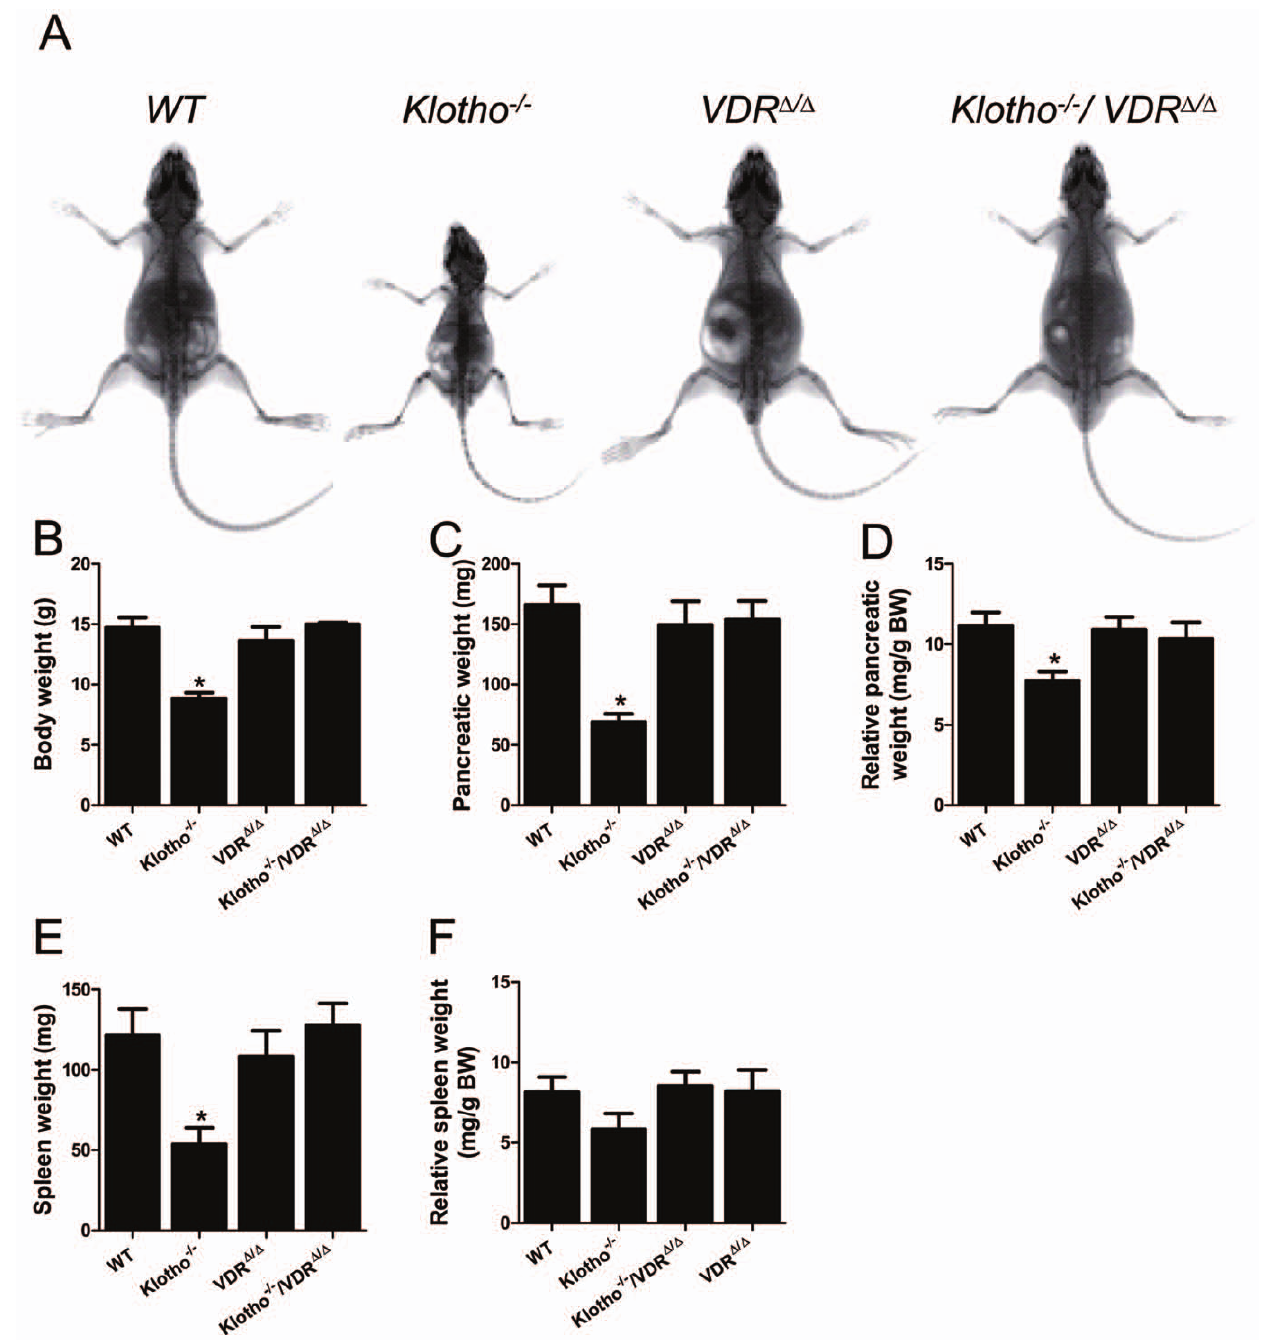
Figure 1. Dwarfism and organ atrophy in Klotho 2 / 2 mice is rescued by ablation of VDR function. ( A ) X-ray image of 4-week-old WT , Kl 2 / 2 , VDR D / D , and Kl 2 / 2 /VDR D / D mice on rescue diet shows dwarfism in Kl 2 / 2 mice. VDR D / D and compound mutants display normal body size. ( B–F ) Relative to WT controls, Kl 2 / 2 mice show reduced body weight (BW), reduced absolute and relative organ weight of the pancreas, and reduced absolute but not relative organ weight of the spleen. Body weight and organ weights are indistinguishable between VDR D / D and compound mutants. All animals were fed the rescue diet. Each data point is the mean 6 SEM of 4–8 animals per genotype. * denotes P , 0.05 vs. WT mice, 1-way ANOVA followed by Student-Newman-Keuls test. doi:10.1371/journal.pone.0031376.g001 the presence of altered membrane expression of TRPV5 in our calcium concentrations in the range of 5–10 mmol/mmol creati- study might be explained by the rapid skeletal growth, the very high nine, which is very high. In addition, because PTH increases the bone turnover, and the high concentration of urinary calcium in 4- expression and activates the TRPV5 channel [23,24], the slightly week-old mice on rescue diet, potentially masking more subtle higher PTH levels in VDR and compound mutants might also contribute to masking the urinary calcium leak in compound differences in renal calcium handling. All groups showed urinary